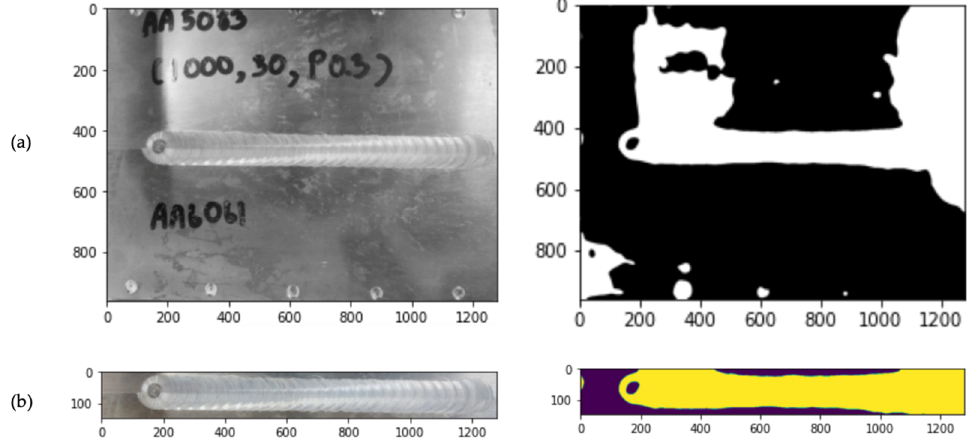
Figure 4. Image segmentation ( a ) before segmentation and ( b ) after segmentation.